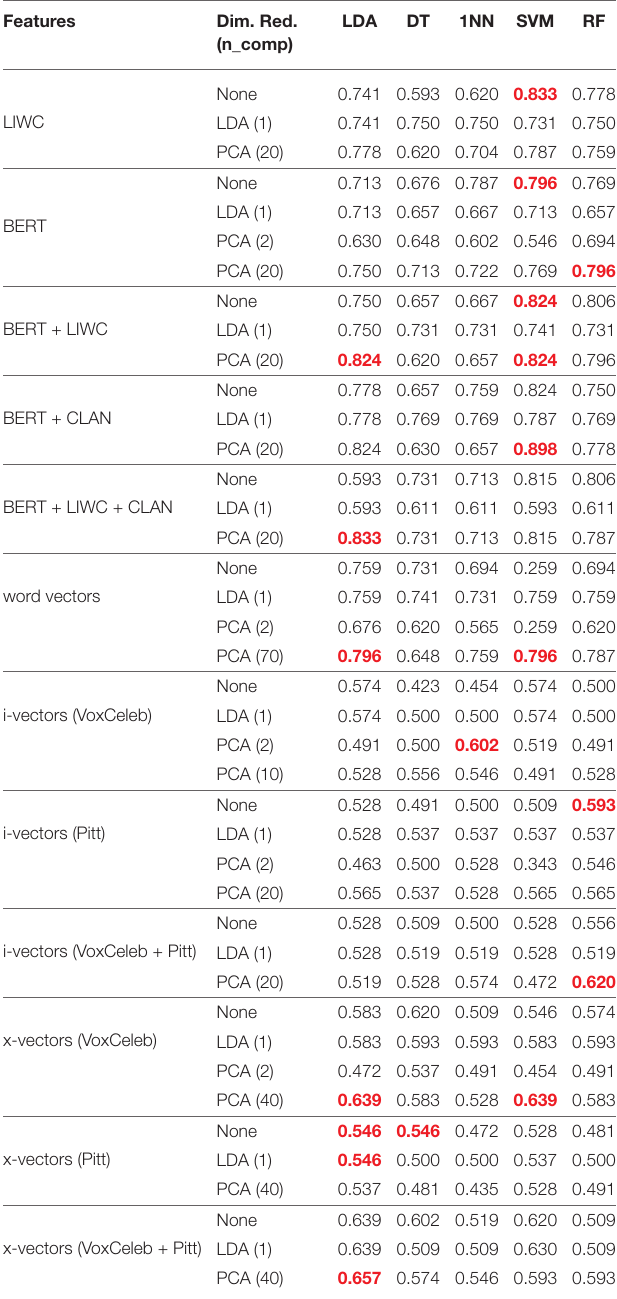
TABLE 4 | Accuracies for classifiers evaluated on the test set. The test set results for the best-performing models during cross-validation are red.